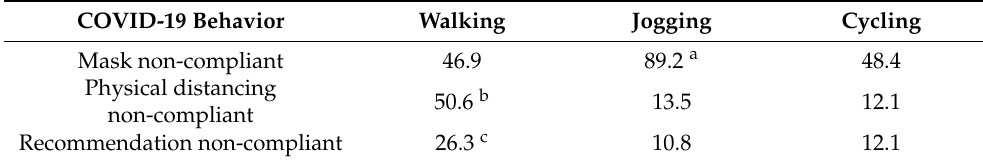
Table 2. COVID-19 behaviors by physical activity type.